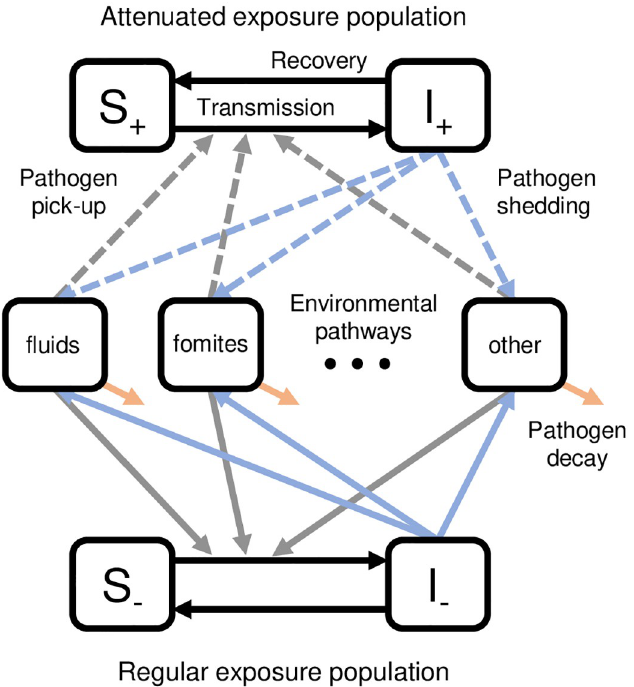
Fig 2. Environmental transmission in an intervention study. The shared environment has multiple environmental pathways that correspond to transmission routes depicted on a traditional F-diagram. The first population (subscript +) adheres to an intervention or has preexisting WASH conditions that provide the same protection as the intervention; this population has attenuated exposure to and attenuated shedding into the environment (dashed lines). The second population (subscript -) is not covered by the study or does not adhere to the intervention and has no preexisting WASH conditions; this population has regular exposure and shedding (solid